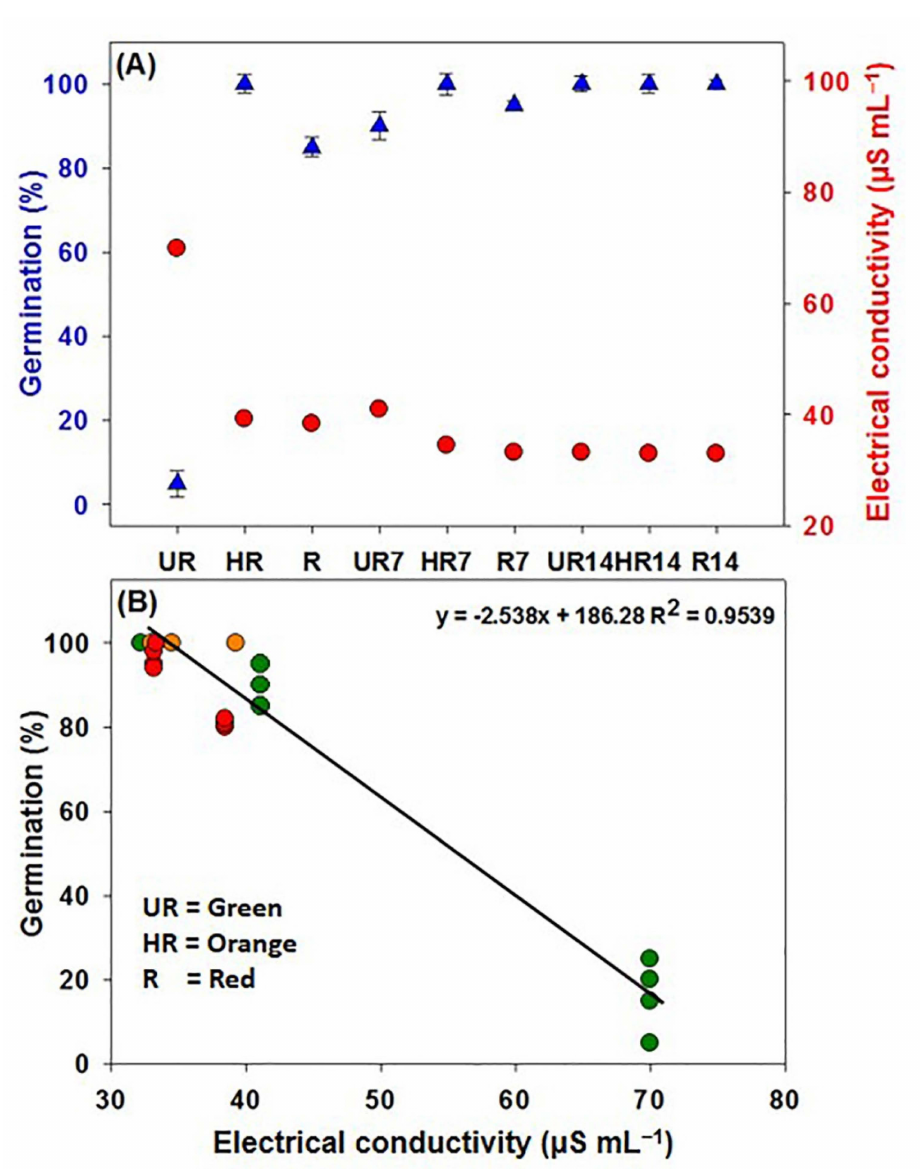
Figure 8. Percentage of germination and electrical conductivity ( A ) of habanero pepper seeds and correlation between the germination percentage and electrical conductivity ( B ) of habanero pepper seeds from unripe (UR = Green circles), half-ripe (HR = Orange circles), and ripe (R = Red circles) fruits; unstored (US) and stored for 7 and 14 days